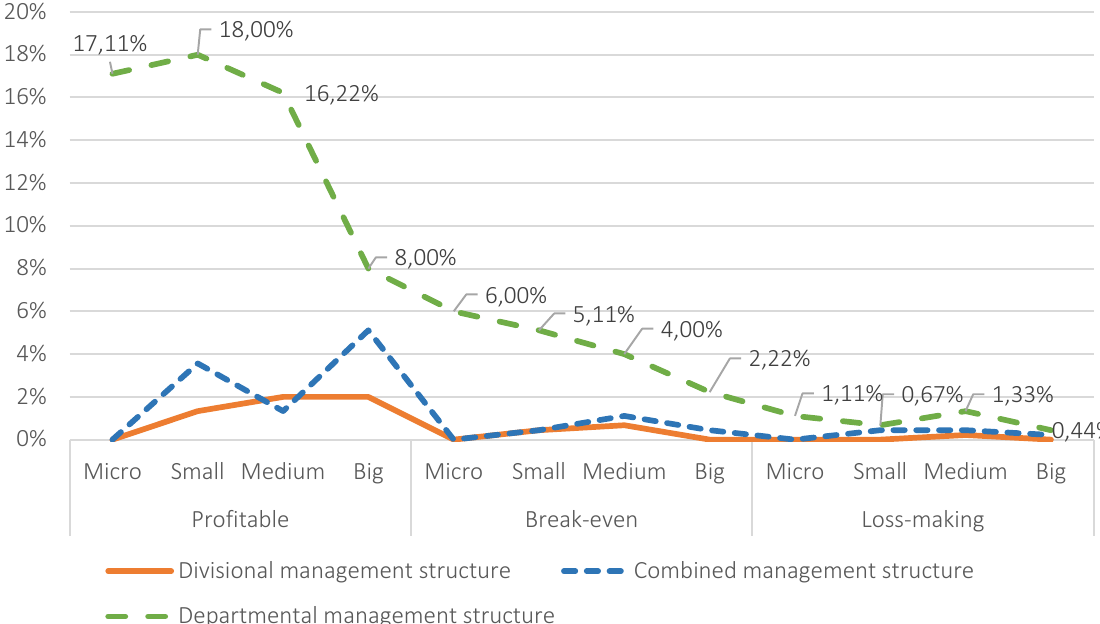
Figure 3. Percentage expression of dependence between management and organizational structure, size, and profitability of